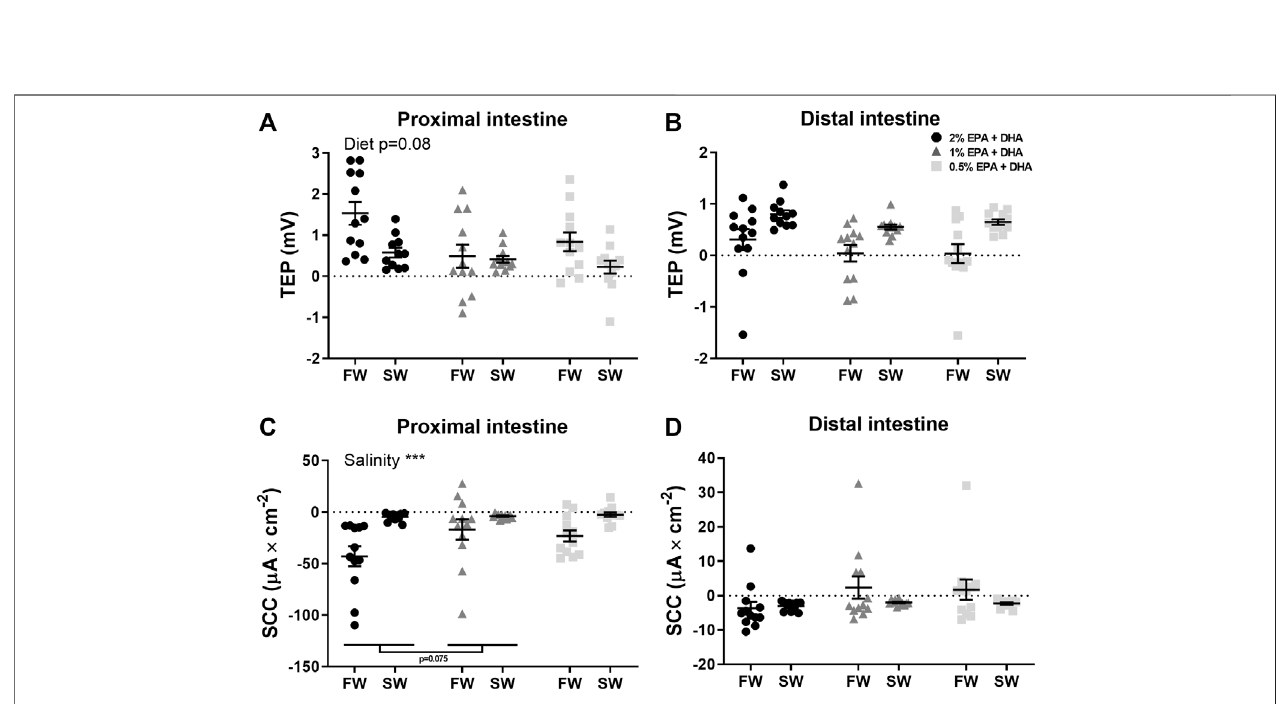
FIGURE2| Activeintestinaliontransportassessedastransepithelialpotentialdifference(TEP; (A,B) andshort-circuitcurrent(SCC; (C,D) infreshwater(FW)smolts and seawater (SW) acclimated Atlantic salmon fed different levels of omega-3. Statistics: 2-way ANOVA where main effects were compared with Tukey´s multiple comparisons test. Signi fi cant effects from the post-hoc test are reported as * p < 0.05 and *** p < 0.001. Data are presented as individual values with the horizontal line representing the mean and the vertical lines SEM.